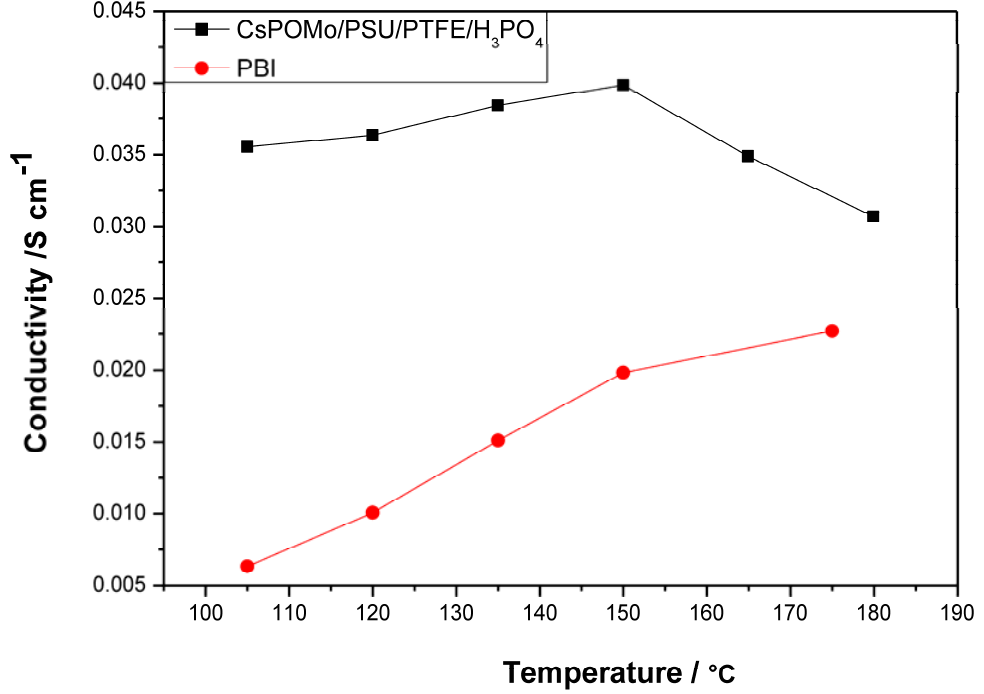
Figure 4. Conductivities of CsPOMo/PSU/PTFE composite membrane and polybenzimidazole (PBI) membrane loaded with H <1%. The thickness of both membranes is 30 μ